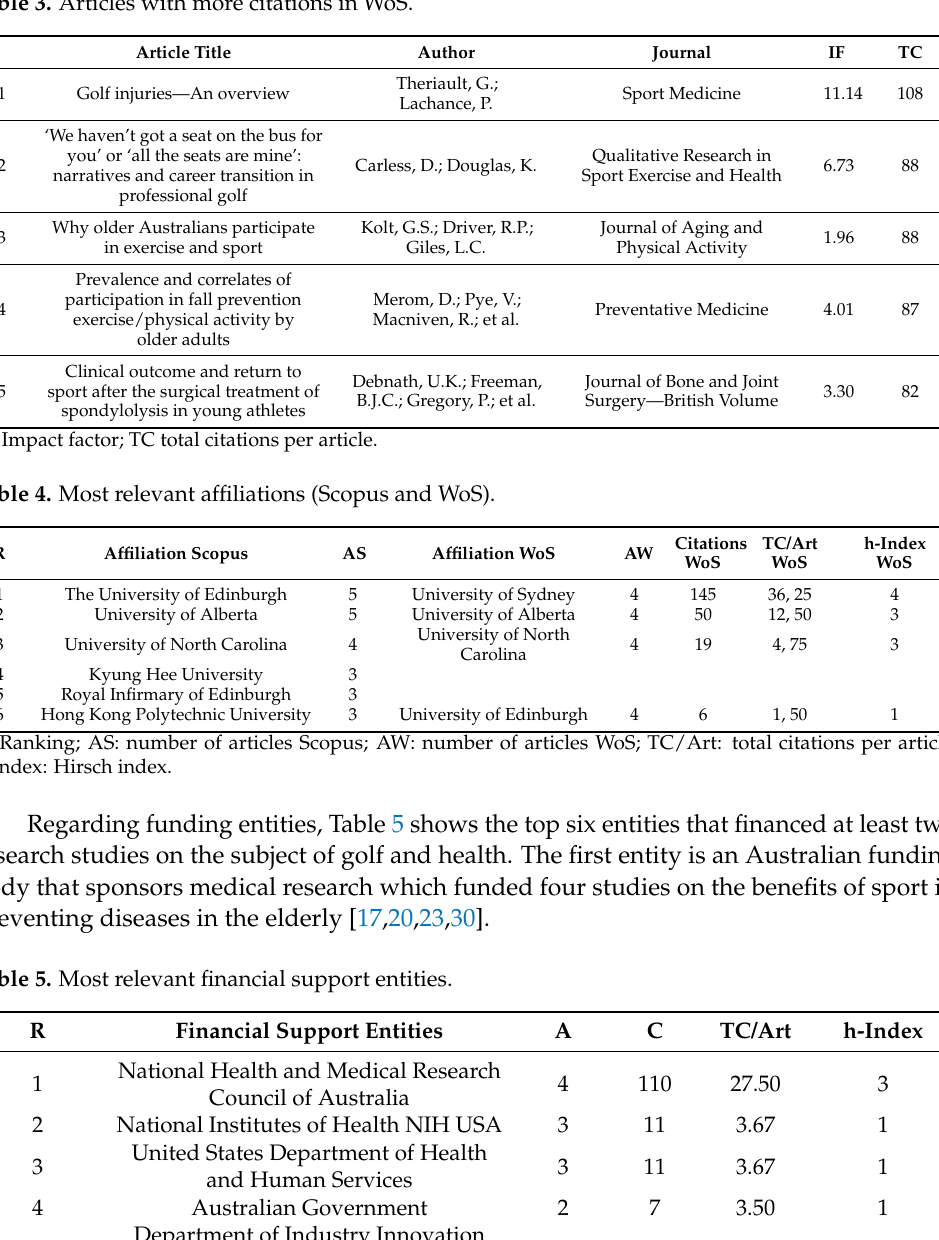
Table 3. Articles with more citations in WoS.